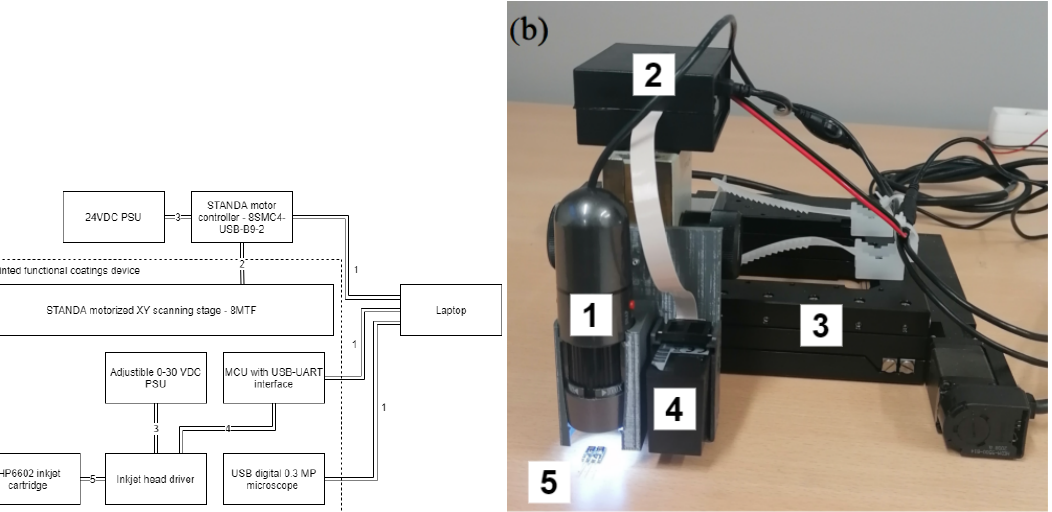
Figure 1. Inkjet printing system; ( a ) block diagram: 1—serial communication; 2—stepper motor cable; 3—power cable; 4—control cable; 5—cartridge cable; ( b ) a photograph of the system: 1—camera, 2—printing controller and driver, 3—two-axis positioning system, 4—cartridge, 5—CMUT